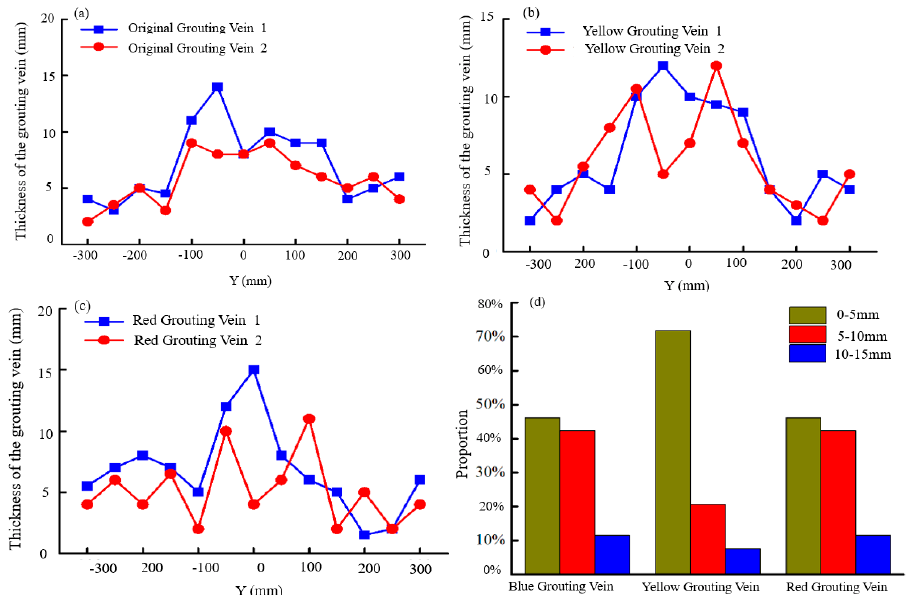
Figure 11. Thickness distribution of the grouting veins in the C (600 mm) section: ( a ) thickness distribution of the original grouting veins; ( b ) thickness distribution of the original grouting veins; ( c ) thickness distribution of the red grouting veins; ( d ) thickness distribution proportions of the different grouting veins.